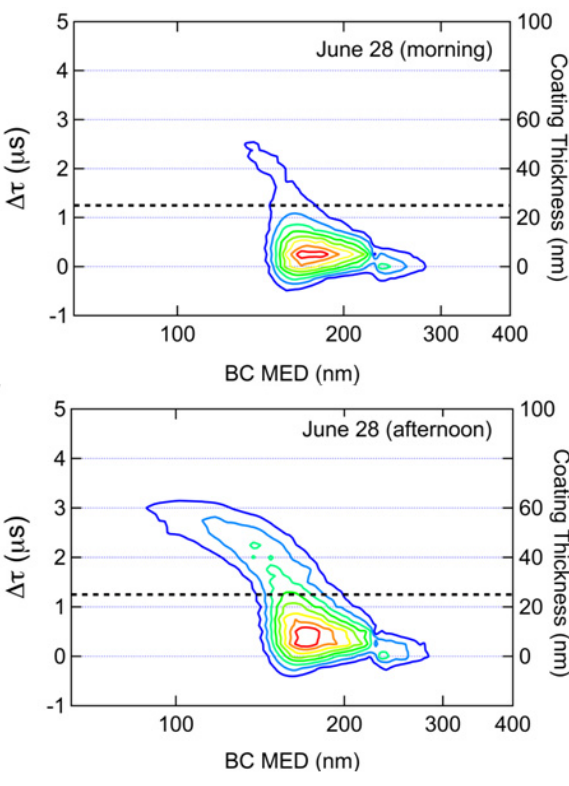
Fig. 15. The time delay between the observance of the incan- descence signal peak relative to the peak in the scattering signal (incandescence-scattering lagtime, 1τ) is plotted as a function of the BC mass equivalent diameter (MED) for the morning and after- noon flights conducted on 28 June. Number concentration contours are normalized to unity (red = 0.9, blue = 0.2) to highlight the dif- ferences between the two flights. Since the non-refractory coating must be burned off before the BC core will incandesce, the recorded lagtime can serve as a proxy for coating thickness – the larger the lagtime, the greater the coating thickness. The morning ensemble lagtimes are dominated by thinly coated soot whereas in the after- noon an increase in the fraction of thickly coated larger diameter BC core is